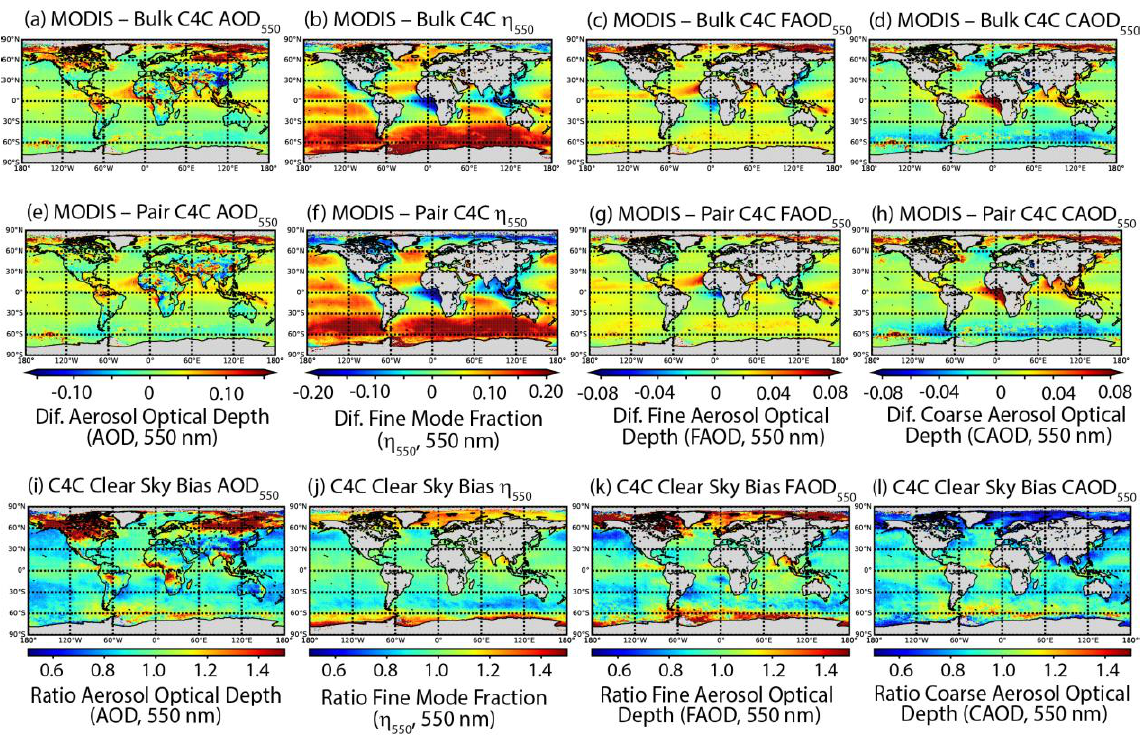
Figure 3. Differences and ratios between average products. Top row: The difference between total average Aqua MODIS and total average ICAP C4C AOD products including ( a ) total AOD 550 ; ( b ) Fine mode fraction ( η 550 ); ( c ) Fine mode AOD 550 (FAOD 550 ); and ( d ) Coarse mode AOD 550 (CAOD 550 ). Middle row: ( e – h ) Same as ( a – d ) but for only those data points that had pairwise correspondence between Aqua MODIS and the C4C. Lower row: ( i – l ) the ratio of C4C AOD 550 products (for those points with Aqua MODIS retrievals) to the bulk average product (i.e., the clear sky fractional bias as estimated from the C4C).